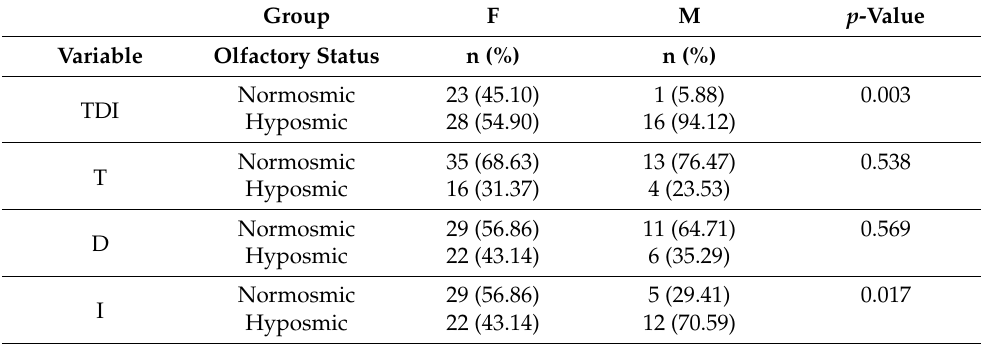
Table 5. Distribution of female and male patients classified as normosmic or hyposmic based on their overall TDI olfactory status and separately for their Threshold (T), Discrimination (D), and Identification (I) olfactory